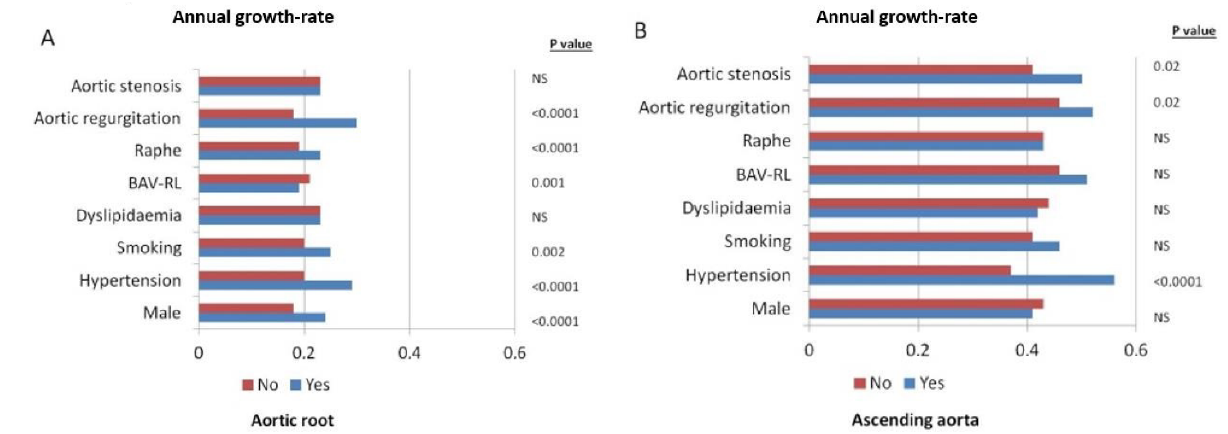
Figure 2. Aortic root ( A ) and ascending aorta ( B ) annual growth-rate diameters according to different baseline characteristics. During the study period, 232 patients (68%) maintained a normally-functioning Table 2. Factors associated with annualized aortic diameter progression (mm/year) identified by univariate and multivariable linear regression analysis.